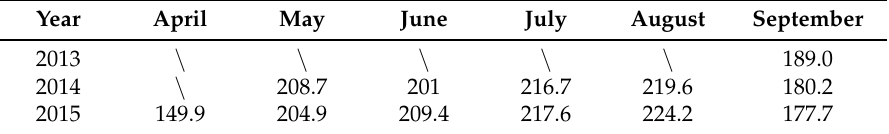
Table 3. Actual monthly evaporation of EJL (mm).